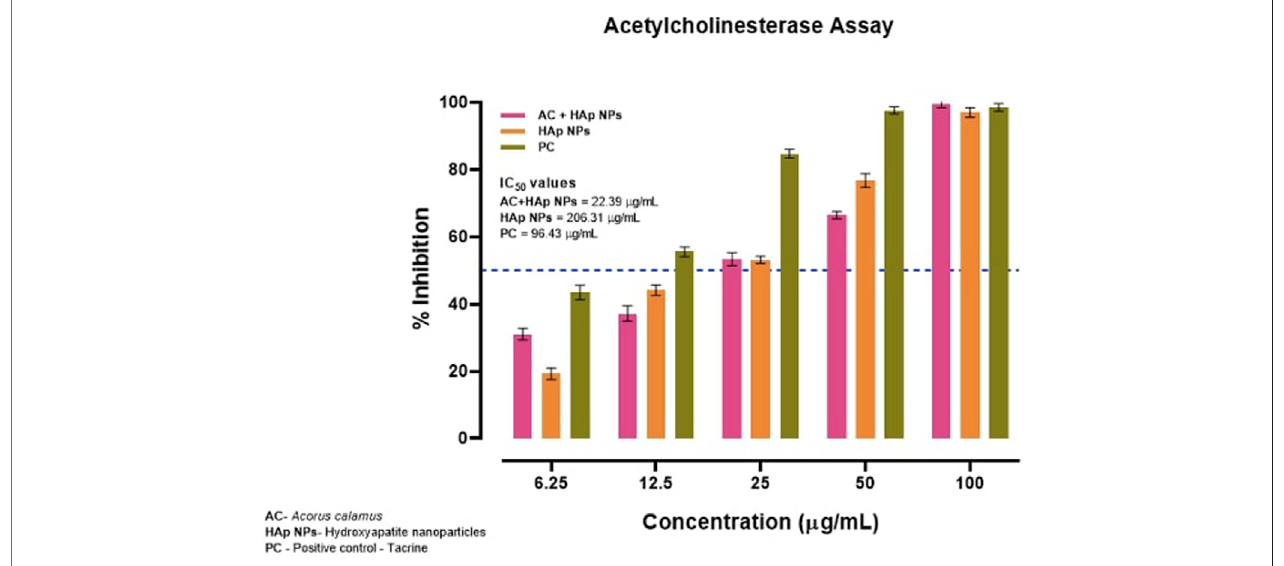
FIGURE 6 | Anti-acetylcholinesterase activity of HAp NPs derived from A. calalmus , pure HAp NPs and Tacrine as positive control.